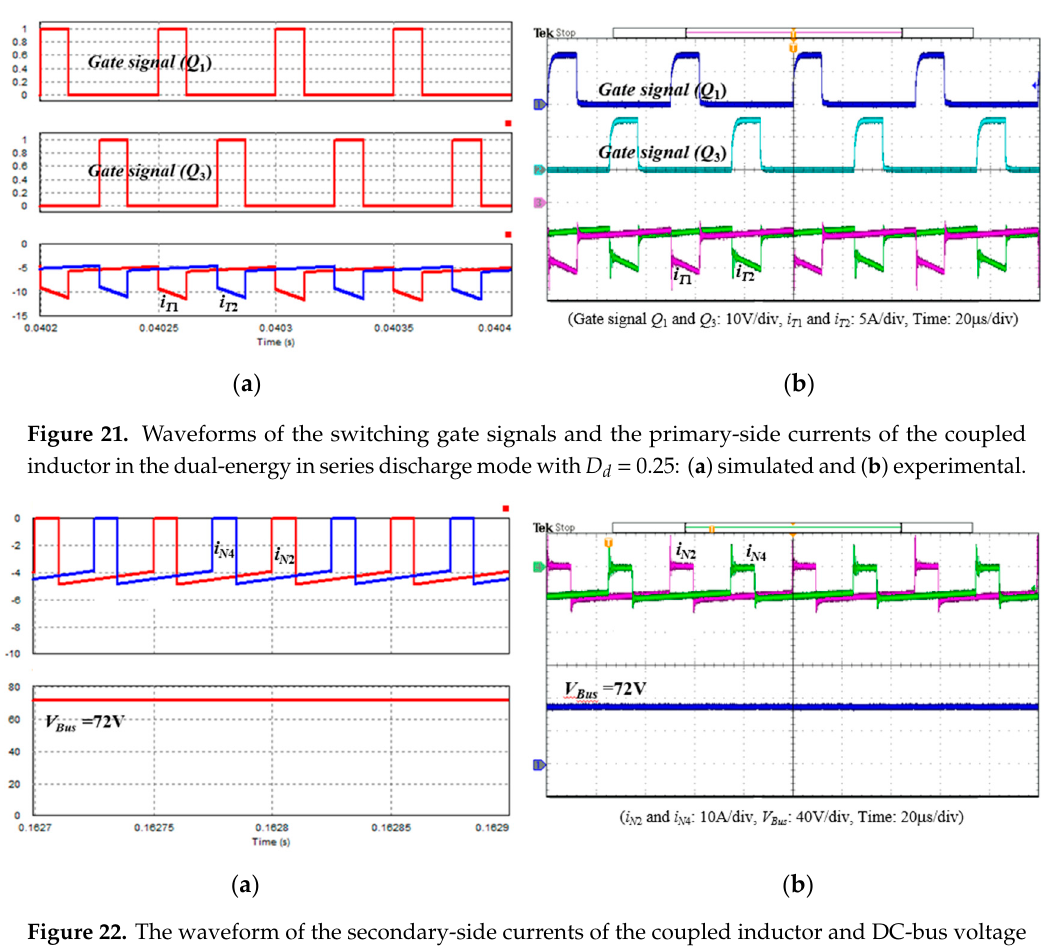
Figure 22. The waveform of the secondary-side currents of the coupled inductor and DC-bus voltage in the dual-energy in series discharge mode with D d = 0.25: ( a ) simulated and ( b ) experimental.